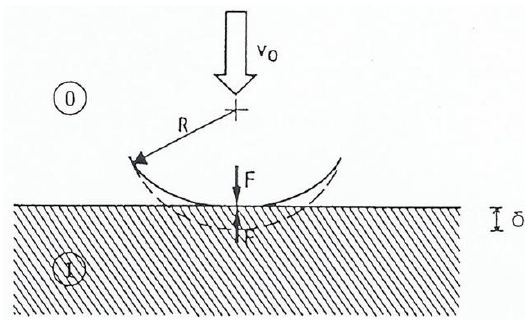
Figure A1. Impact between the moving mass and the elastic semi-infinite surface.